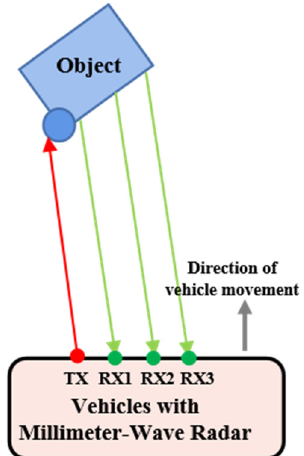
Figure 4. Millimeter-wave radar antenna principle.